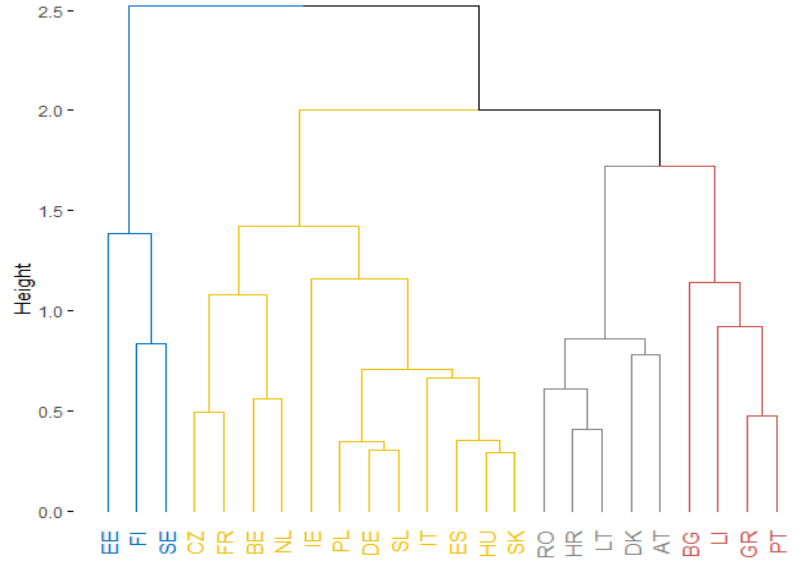
Figure 1. Cluster dendrogram for “smart and efficient energy systems”. Source: Authors’ study based on [75].